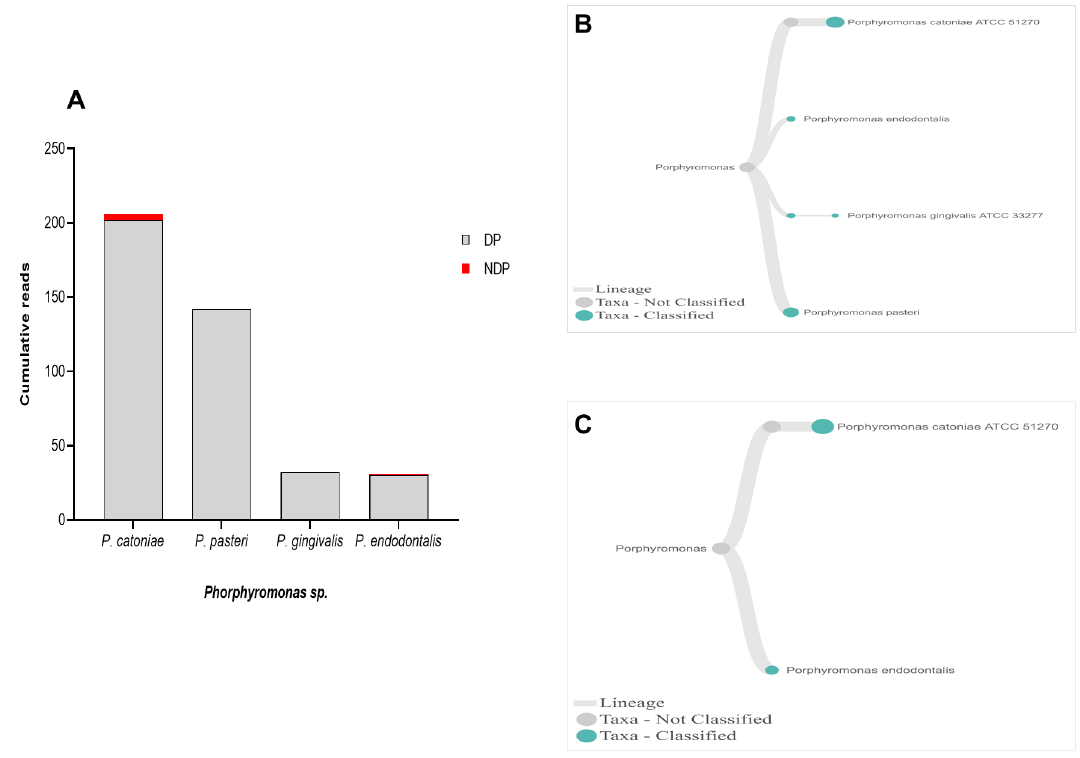
Figure 3. Porphyromonas sp. in pooled subgingival microbiota samples obtained from diabetic (DP) and non-diabetic (NDP) patients. ( A ) Abundance of Porphyromonas sp; ( B and C ) dendrograms showing the variability of Porphyromonas sp . in DP ( B ) and NDP ( C )